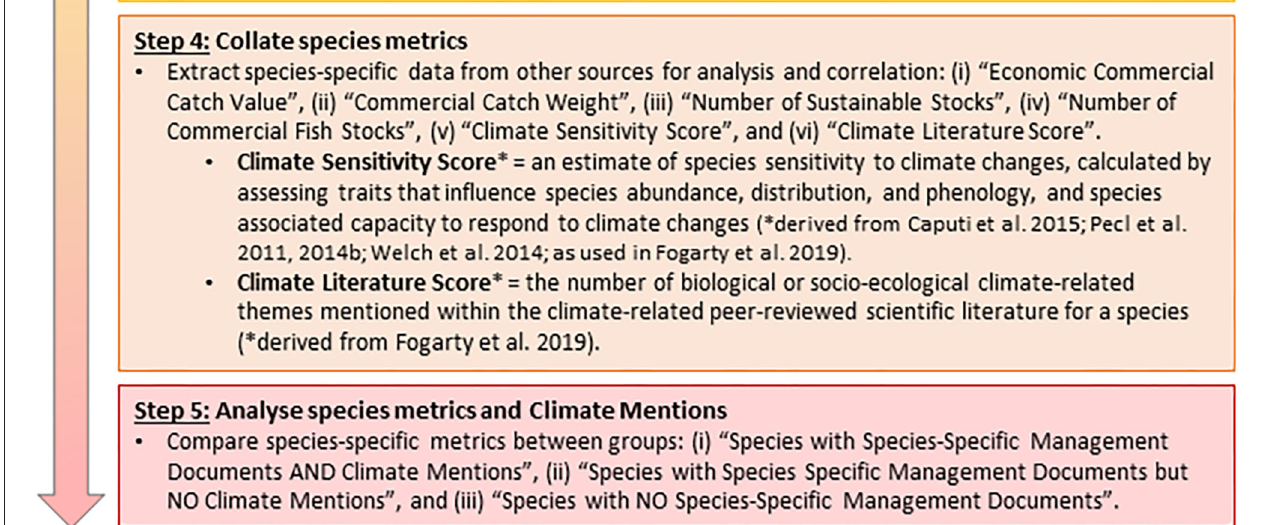
FIGURE 2 | Flow diagram summarizing the methods used for investigating the extent to which “climate” and climate-related themes are mentioned within Australian state fisheries management plans and other directive documents, and what factors may influence